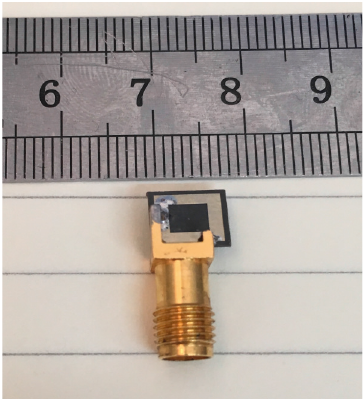
Figure 13: Photographs of the fabricated CP antenna showing the ground view.